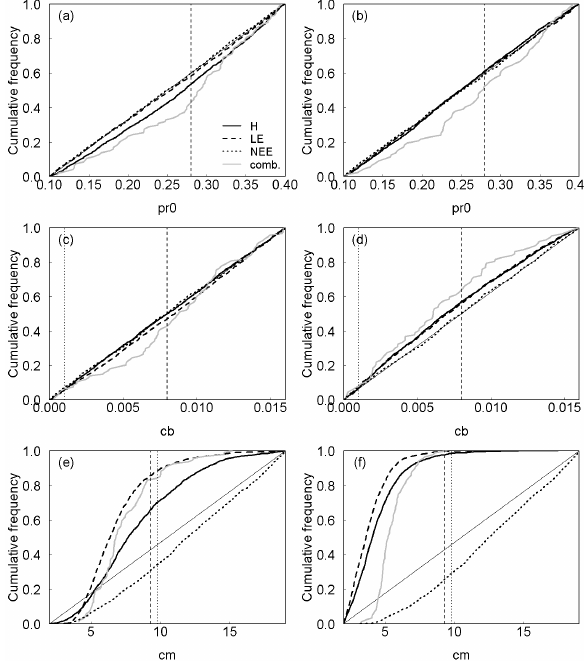
Fig. 6. Cumulative likelihood distributions for the model param- eters pr0, near-IR leaf reflectivity [ − ], (a) and (b) , cb, intercept Figure 6. Cumulative likelihood distributions for the model parameters pr0 (near-IR leaf 3 of Ball-Berry formula [molm − 2 s − 1 ], (c) and (d) , and cm, slope reflectivity [-], a and b), cb (intercept of Ball-Berry formula [mol m -2 s -1 ], c and d) and cm 4 of Ball-Berry formula [ − ], (e) and (f) , for the 10% best param- (slope of Ball-Berry formula [-], e and f) for the 10% best parameter sets for the single-5 eter sets for the single-objective and combined coefficients of ef- objective and combined coefficients of efficiency (left column: IOP-1, right column: IOP-2). 6 ficiency (left column: IOP-1, right column: IOP-2). The thin The thin black diagonal represents a uniform parameter distribution. In (a) and (b) the dashed 7 black diagonal represents a uniform parameter distribution. In (a) vertical line depicts the reference parameter for the Waldstein-Weidenbrunnen site. In (c) to 8 and (b) the dashed vertical line depicts the reference parameter for (f) the dashed vertical line shows the original ACASA parameter whereas the dotted vertical 9 the Waldstein-Weidenbrunnen site. In (c) to (f) the dashed verti- line depicts the reference value of the PSN6 model for our site. 10 cal line shows the original ACASA parameter whereas the dotted vertical line depicts the reference value of the PSN6 model for our